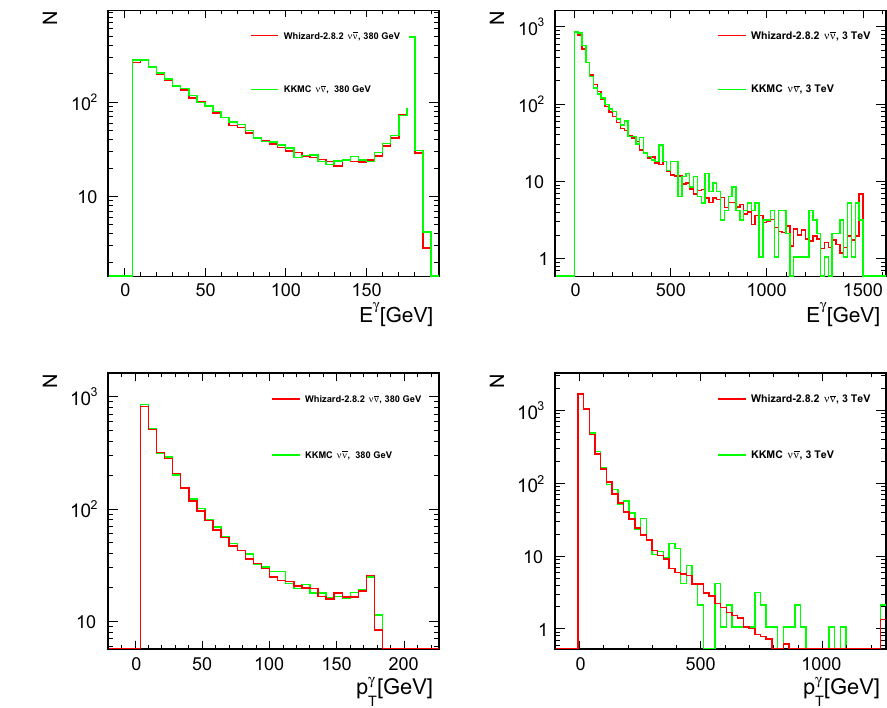
Fig. 6 Distributions of the photon energy (upper row) and transverse momentum (lower row) in the neutrino pair production events generated by Whizard and the KK MC, for collision energy of 380GeV (left) and 3TeV (right), after hard photon selection. Distributions are normalised to the number of events expected for integrated luminosity of 1fb −